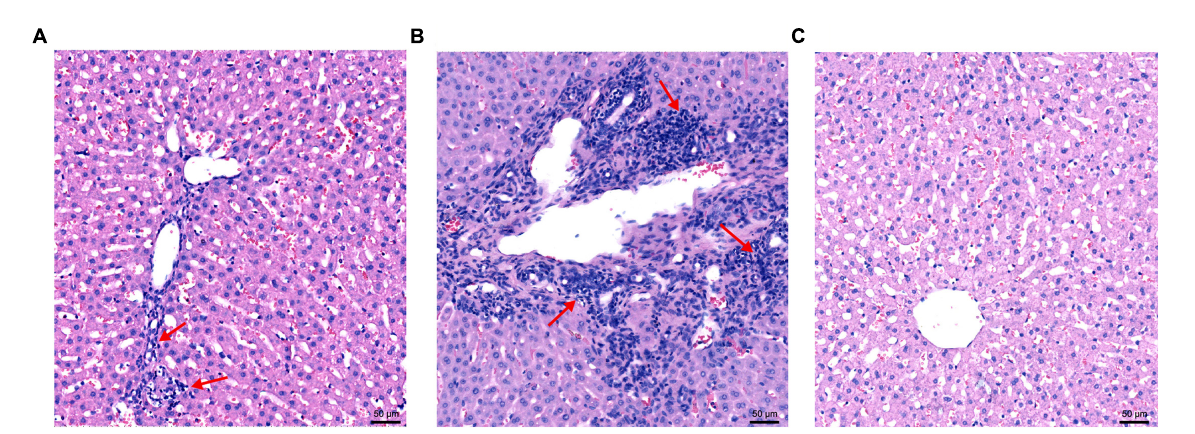
FIGURE6 The microscopic lesions of liver sections in necropsied rabbits. (A) Liver tissues from rabbits with slight lymphocytic venous periphlebitis in the nb53 group. (B) Severe lymphocytic venous periphlebitis in hepatocytes in virus only or nb anti-PCV2 groups. (C) No obvious pathological signs of microscopic lesions in the rabbits of the nb14 and 1B5 groups.